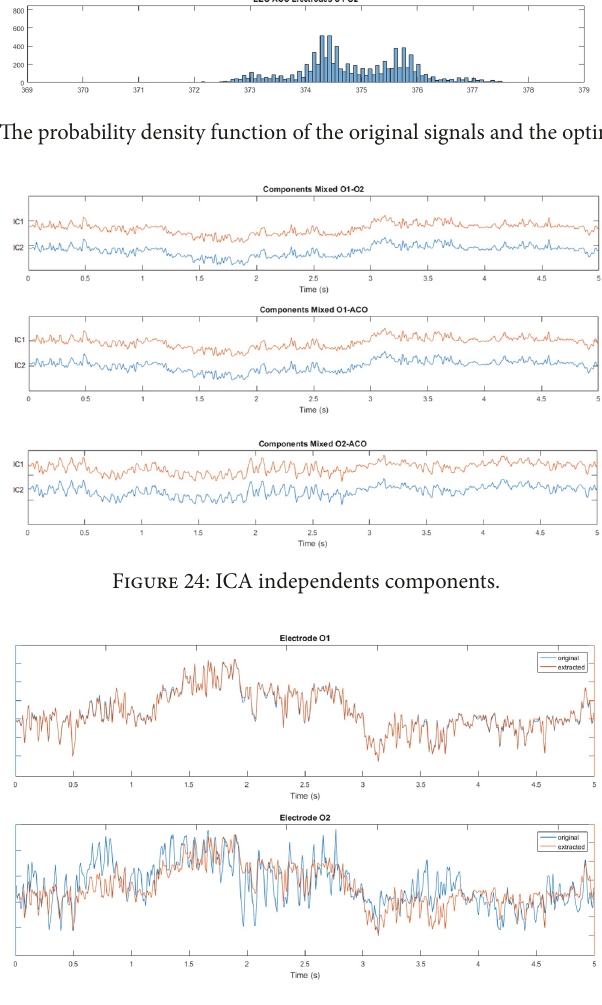
Figure 25: Comparison of the original signal and the reconstructed signal (extracted) implementing in the ICA model the mixture of signals O1 and